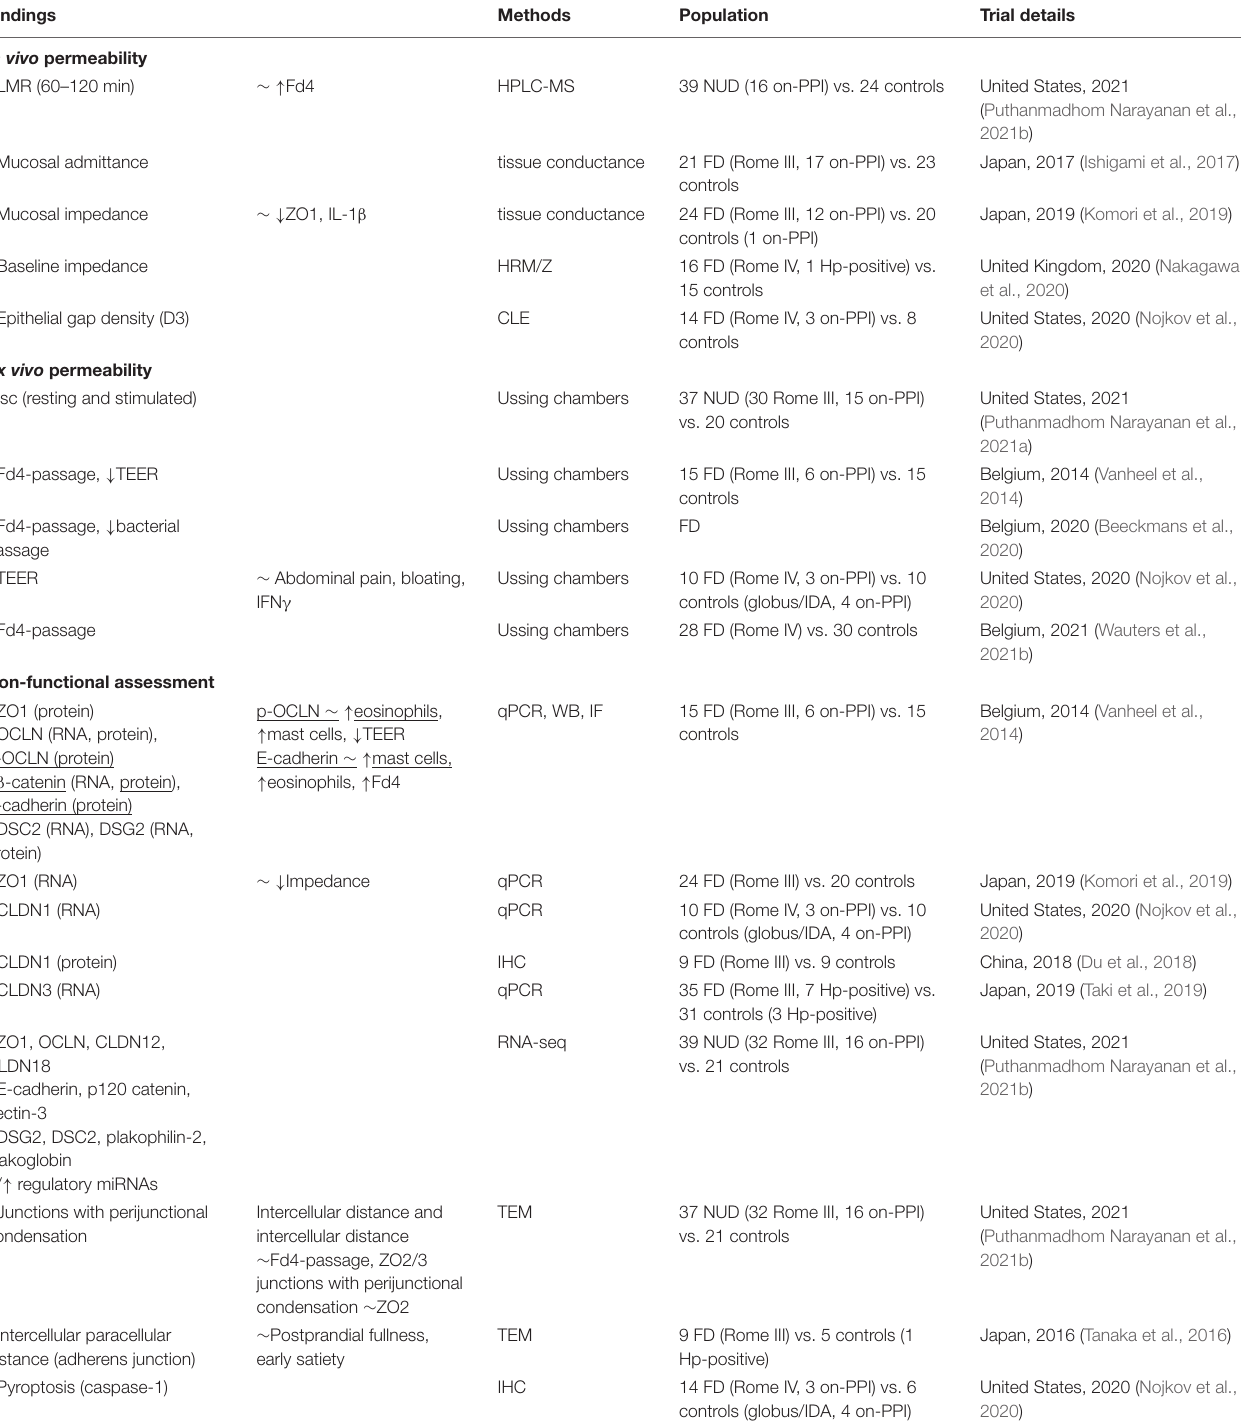
TABLE 2 | Impaired duodenal mucosal permeability in adult Functional Dyspepsia patients.